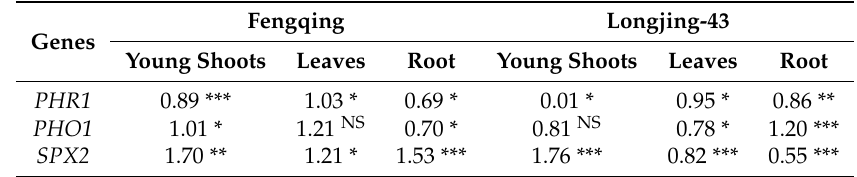
Table 4. qRT-PCR expression of transcription factor genes normalize with reference gene delta-CT ( ∆ C T ) are shown as fold changes (log 2[ − P/+P]